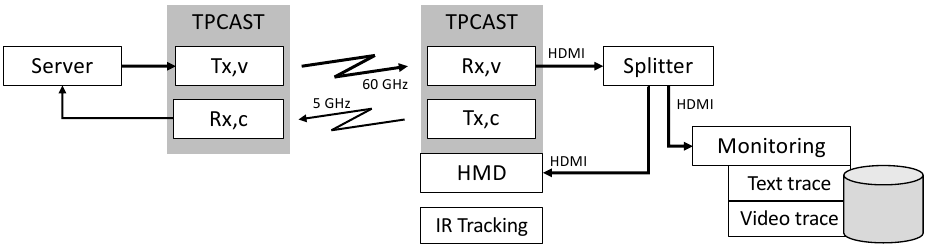
Figure 3. Block diagram of the TPCAST wireless VR testbed (Tx,v: Transmitter of the 60 GHz video link, Rx,v: Receiver of the 60GHz video link, Tx,c: Transmitter of the 5GHz control link, Rx,c: Receiver of the 5GHz control link).